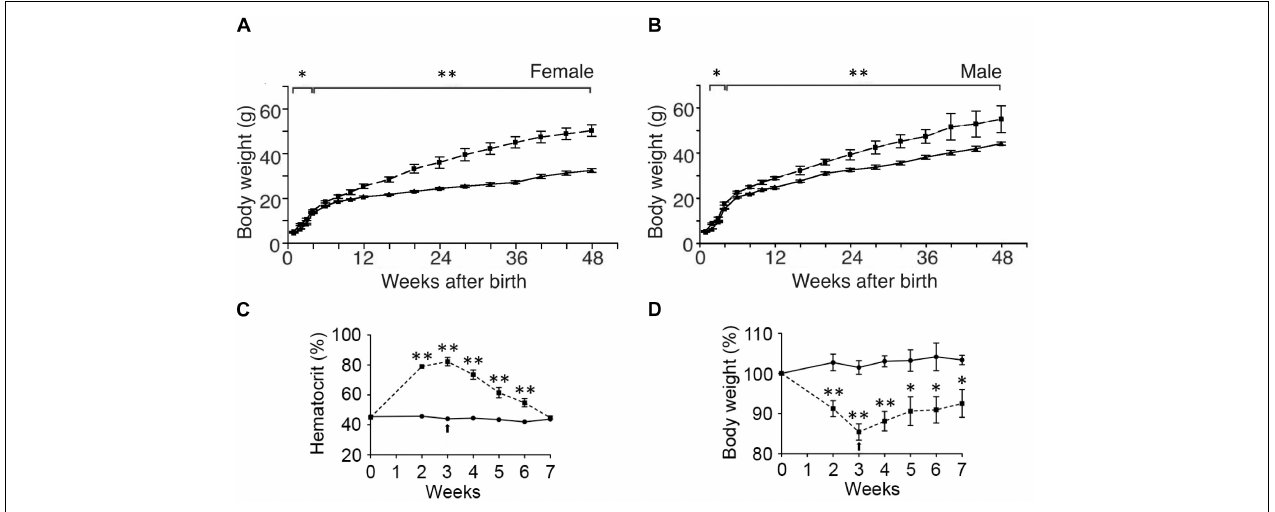
FIGURE 3 | Endogenous and exogenous EPO signaling regulates white fat mass accumulation. (A,B) Body weight to 48 weeks of age are indicated for wild type mice (solid line) and mice with EPOR restricted to erythroid tissue (Suzuki et al., 2002) ( (cid:49) EpoR E ) (dashed line) for females (A) and males (B) . (C,D) Hematocrit (C) and % body weight normalized to starting body weight (D) for male wild type mice subjected to 3 weeks of EPO treatment at 3000 U/kg three times weekly (dashed line) or saline (solid line). Arrow indicates end of EPO treatment. ∗ p < 0.05; ∗∗ p < 0.01 (from Teng et al., 2011b, with